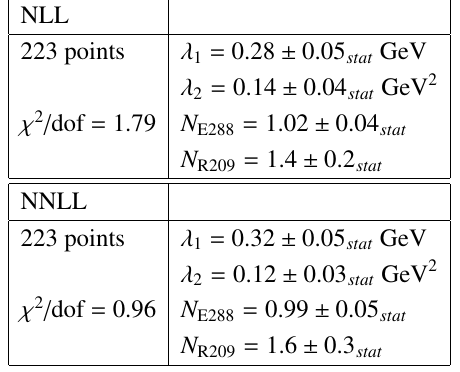
Table 1. Results of our global fit on low-energy [16, 18] and Tevatron data [19–23], with D NP = 0 (Eq. (8)), Q i = Q 0 + q T , at NNLL and NNL accuracies and with the collinear parton distributions from CTEQ10 [27] at NNLO and